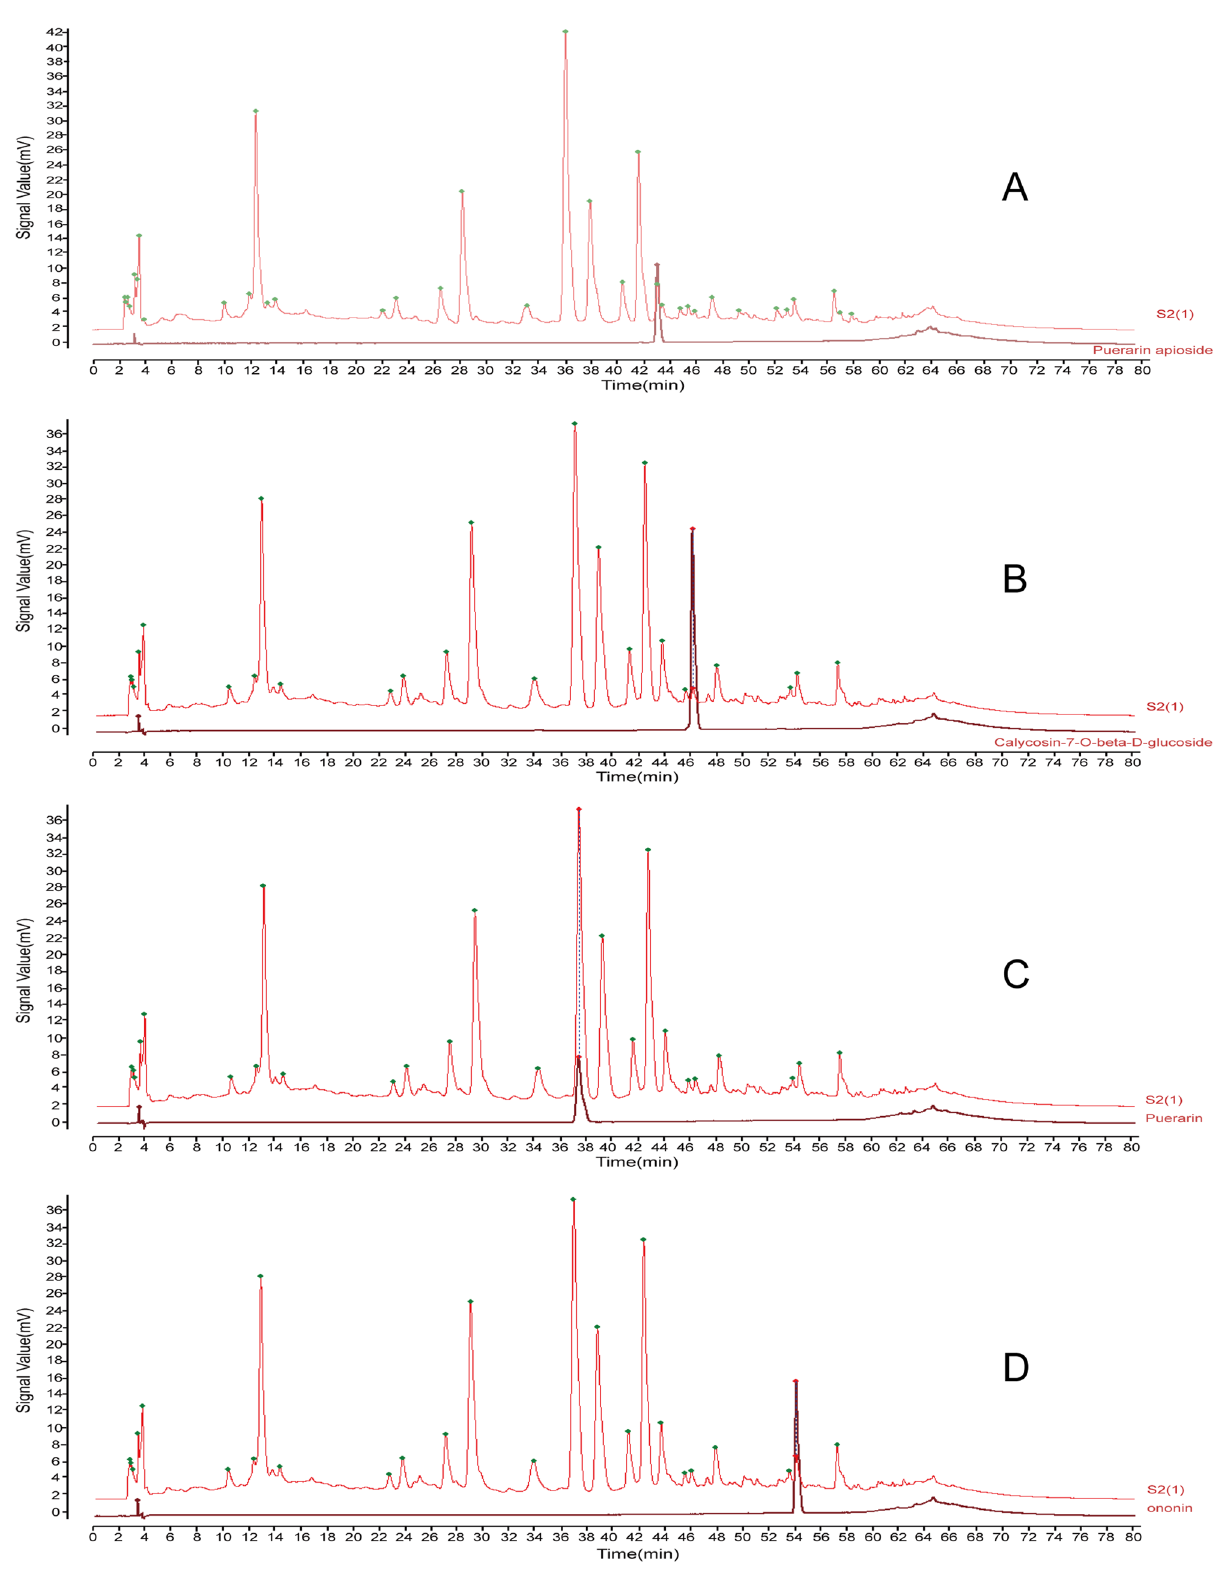
Fig. 3 HPLC chromatograms of a puerarin apioside; b calycosin-7- O -beta- d -glucoside; c puerarin, d